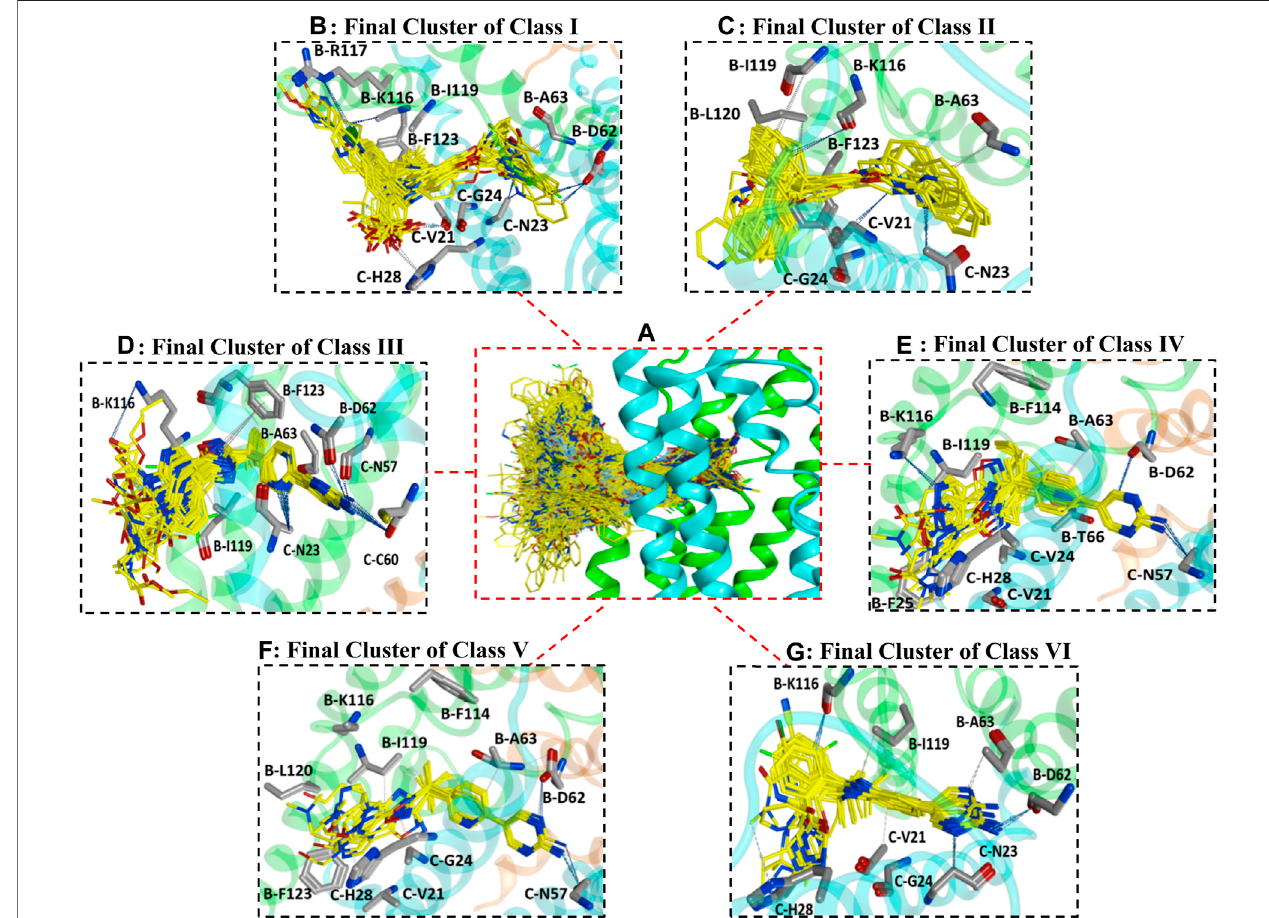
FIGURE2|(A) illustratesthebindingpositionsandchemicalspaceoccupiedbyallgeneratedposesof187FLAPantagonistsbetweenchainsBandCoftheFLAP binding cavity. Chain B is shown in green color, chain C is depicted in blue color, while chain A is depicted in orange color. (B – G) represents binding poses of maximum docked ligands in fi nal clusters from class I to VI respectively obtained from common scaffold-based clustering.